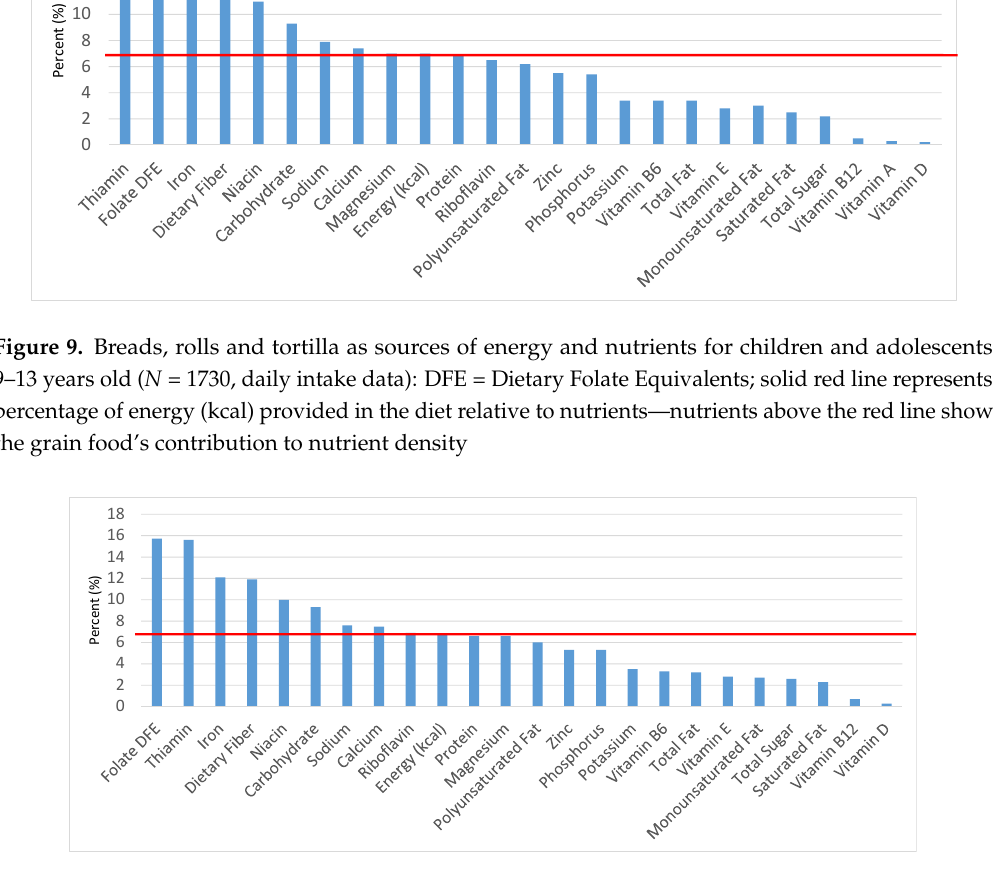
Figure 10. Breads, rolls and tortilla as sources of energy and nutrients for adolescents 14–18 years old ( N = 1508, daily intake data): DFE = Dietary Folate Equivalents; solid red line represents percentage of energy (kcal) provided in the diet relative to nutrients—nutrients above the red line show the grain food’s contribution to nutrient density.